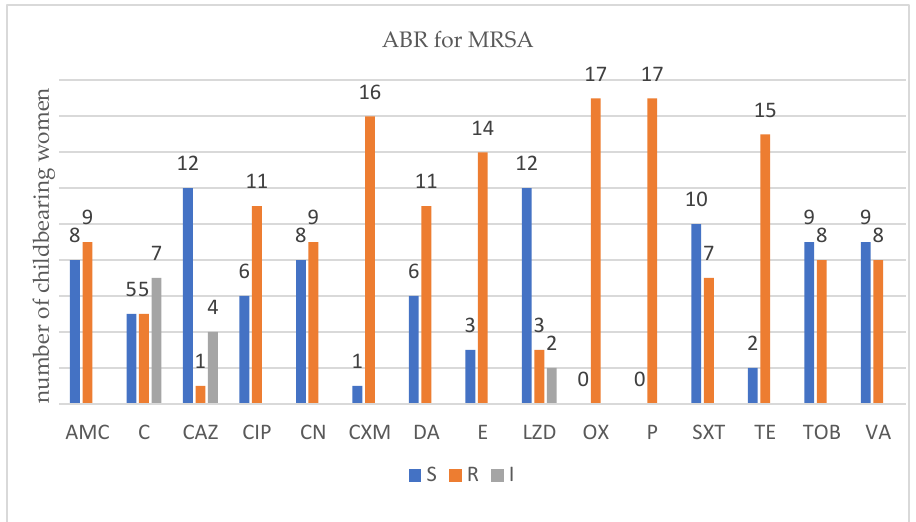
Figure 2. Profile of antibiotic resistance for MRSA; S = sensitive, I = intermediate; R = resistant. Legend: amoxicillin/clavulanic acid (AMC), ceftazidime (CAZ), cefuroxime (CXM), ciprofloxacin (CIP), chloramphenicol (C), clindamycin (DA), erythromycin (E), gentamycin (CN), linezolid (LZD), oxacillin (OX), penicillium (P), trimethoprim-sulfamethoxazole (SXT), tetracycline (TE), tobramycin (TOB), and vancomycin (VA).